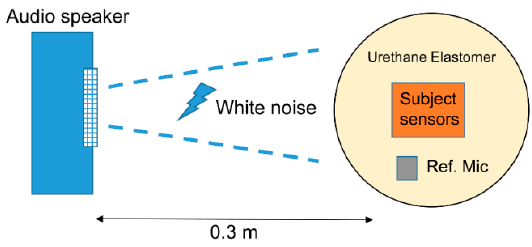
Figure 3. Air-borne noise characteristic experiment.